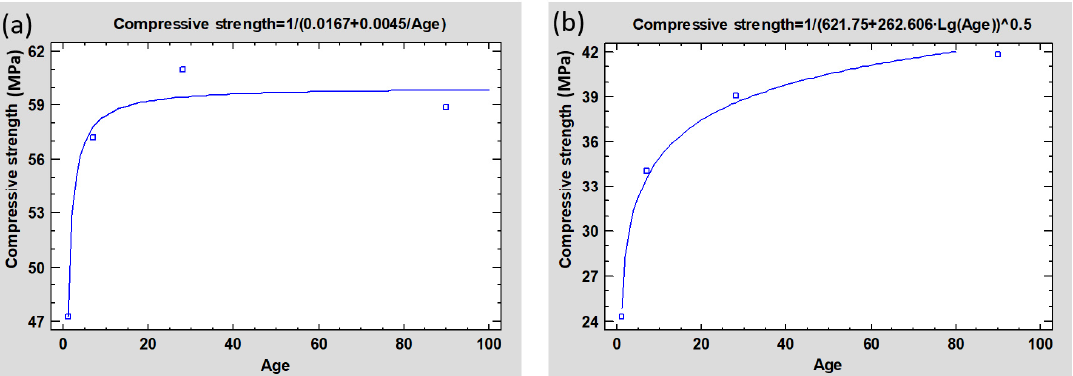
Figure 6. Best-fit models of compressive strength as an age function: ( a ) mix SA0, also valid for mixtures SA25, SA50 and SA100; ( b ) mix SA75.